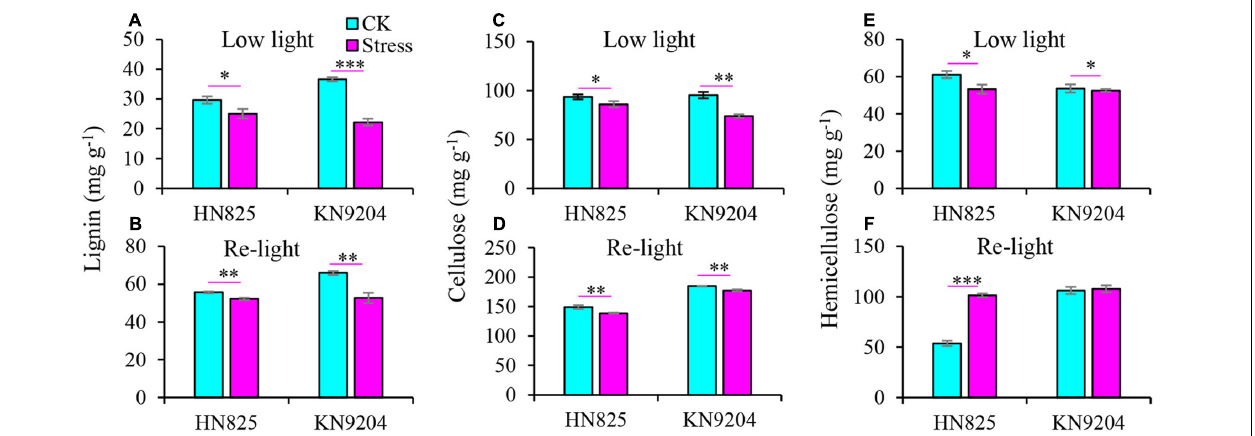
FIGURE 6 | Effect of low light on the contents of lignin (A,B) , cellulose (C,D) , and hemicellulose (E,F) in the spikelet of two wheat cultivars (‘HN825’ and ‘KN9204’). Low light, under low light stress; Re-light, early grain filling stage (20 days after low light treatment). Significant differences between the CK and stress treatments are indicated by asterisks ( ∗ P < 0.05; ∗∗ P < 0.01; ∗∗∗ P < 0.001, Student’s t